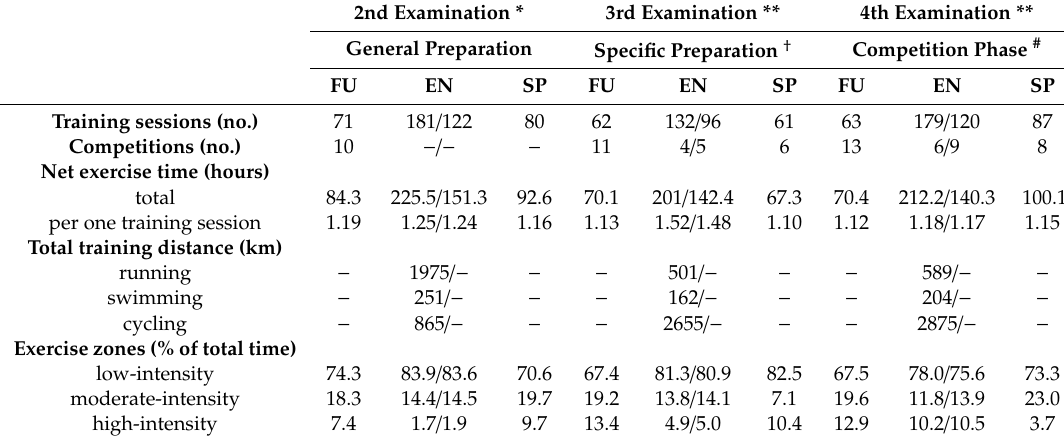
Table 1. Typical structure of training loads in tested futsal players, endurance athletes, and sprinters in successive examinations in a 1 year